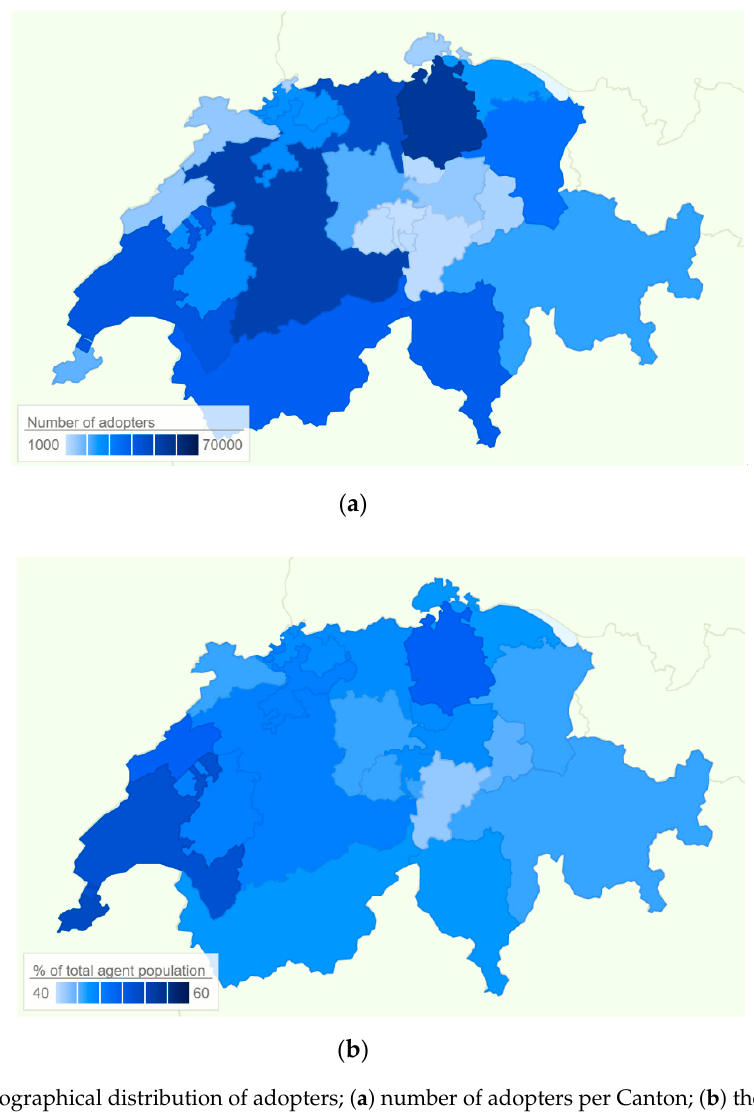
Figure 9. Geographical distribution of adopters; ( a ) number of adopters per Canton; ( b ) the percentage of adopters in total agents.